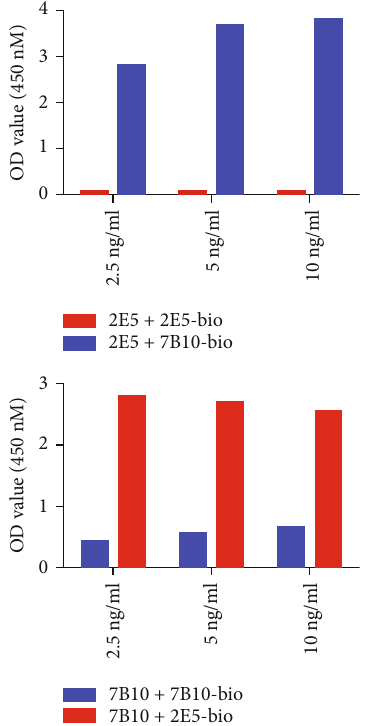
Figure 2: 2E5 and 7B10 monoclonal antibodies (mAbs) recognized di ff erent epitopes. Mutual competition assay by